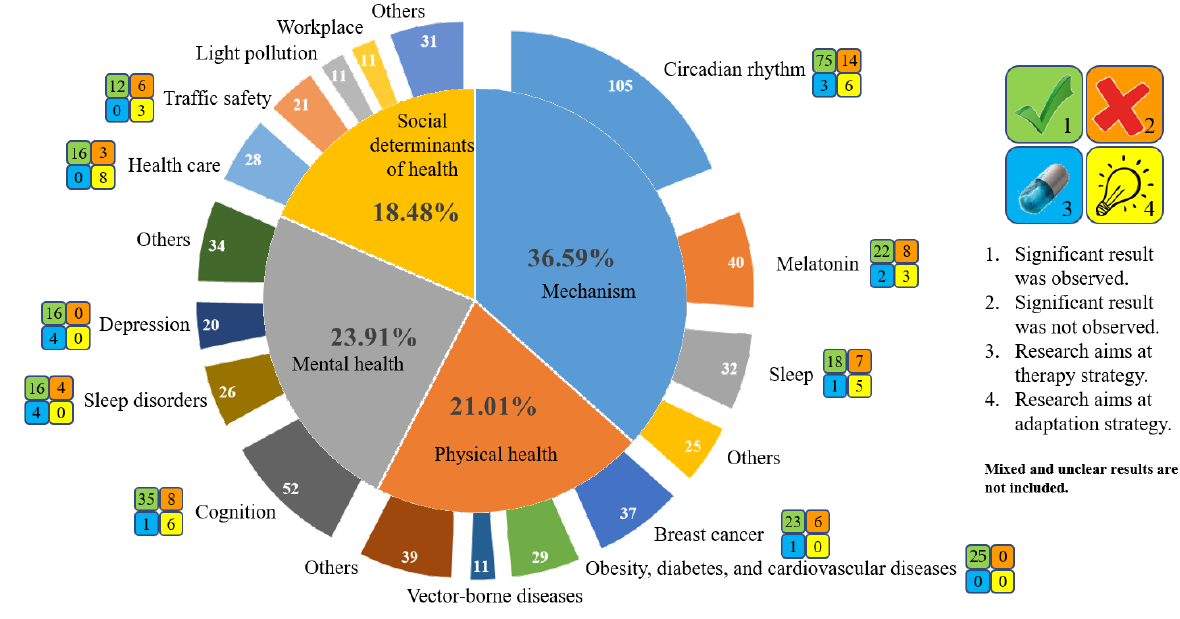
Figure 3. The global distribution of research on ALAN’s effects on human health.